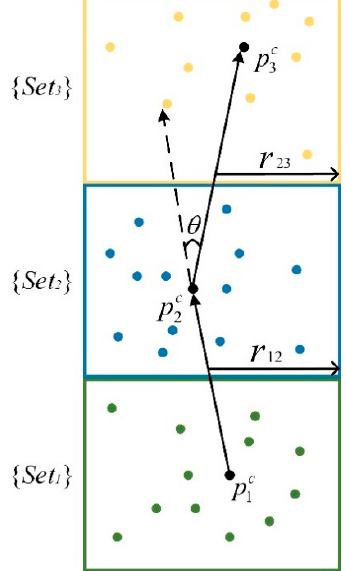
Figure 6. Sketch map of neighboring point sets fusing.